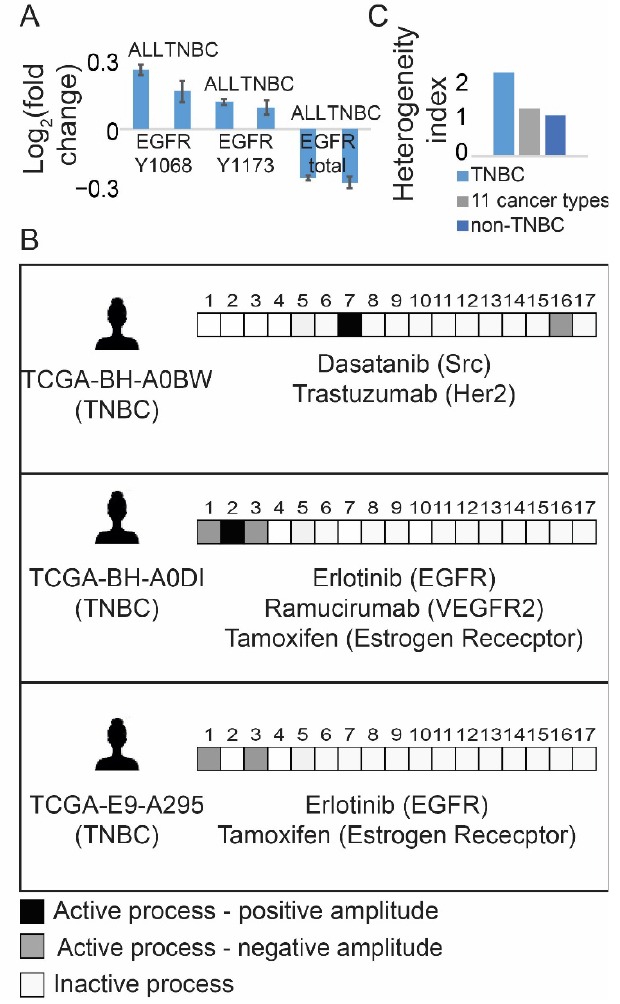
Figure 1. TNBC tissues are represented by different patient-specific signaling signatures, majority of which do not include EGFR. ( A ) Fold changes in expression levels of EGFR and pEGFR in TNBC and non-TNBC tumors are shown. Y1068 and Y1173 are EGFR phosphorylation sites; ( B ) Examples for patient-specific sets of active unbalanced processes are shown. Each sample harbors a set of 1–3 active unbalanced processes (PaSSS), represented schematically by a barcode. In each barcode active unbalanced processes are represented by black or gray squares, inactive white. Negative/positive amplitude denotes how the patients are correlated with respect to a particular process. Suggested PaSSS-based therapies appear below each barcode; ( C ) Heterogeneity index of 3 subgroups, repre- sented by a ratio between the number of distinct PaSSSs and the number of samples in each subset, is shown for the TNBC subset of tissues, the entire set (3467 samples from 11 cancer types) and the subset of non-TNBC samples. (Abbreviations: TNBC — Triple Negative Breast Cancer, PaSSS — Pa- tient-specific signaling signature, EGFR—Epidermal Growth Factor Receptor, VEGFR2—Vascular Endothelial Growth Factor Receptor 2, Her2—Human Epidermal growth factor Receptor 2, Src— Proto-oncogene tyrosine-protein kinase Src).